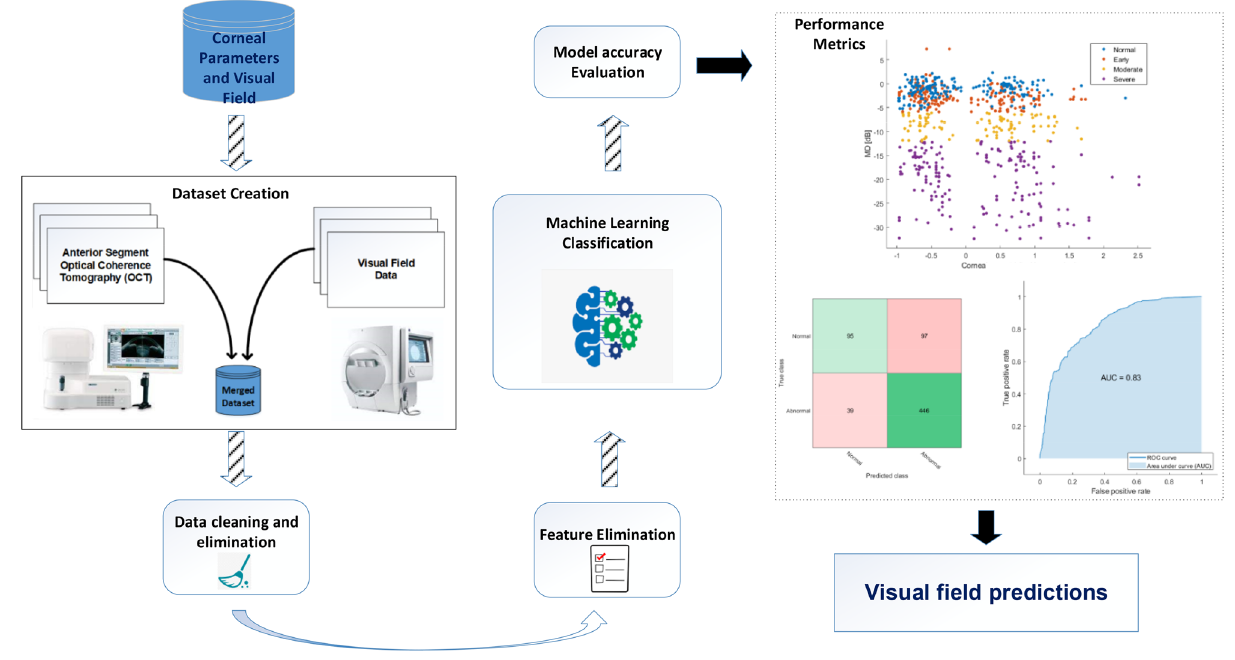
Figure 1. The pipeline of the proposed machine learning